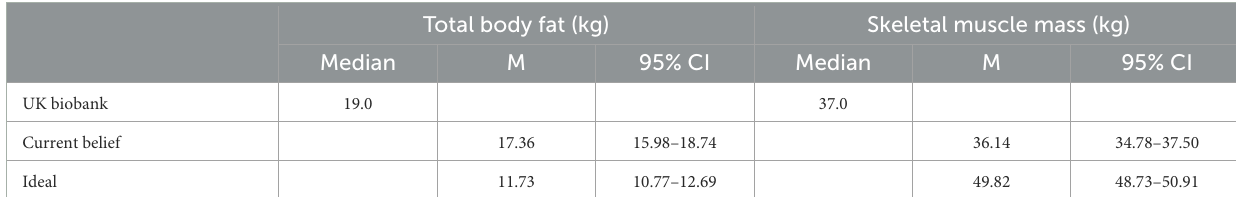
TABLE 2 Body composition for current and ideal beliefs in our male sample ( N = 258), compared to the UK Biobank 50th centile for men’s body